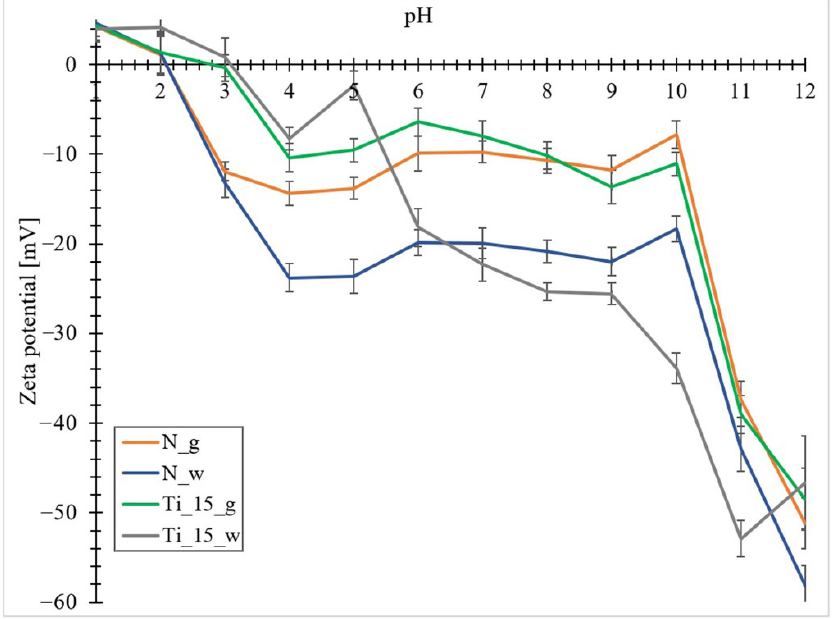
Figure 7. The zeta potential performed in the pH range with values from 1-12, for the analyzed materials (N_g-undoped biomass; N_w-pure diatomaceous biosilica; Ti_15_g-the biomass doped with titanium ions with a concentration of 15 mg Ti/L; Ti_15_w-the biosilica doped with titanium ions with a concentration of 15 mg Ti/L).